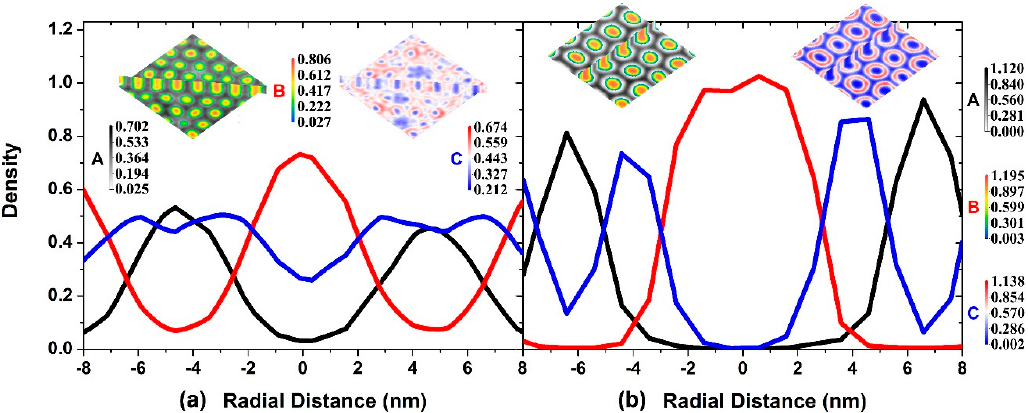
Figure 3. For 3C4 systems at the final equilibrium state, whose density profiles of A, B, and C beads of randomly selected individual cylinders under ( a ) the C[00] interaction and ( b ) C[55] interaction, starting from the center point of the cylinder (set as the original point) and moving along the radial direction, and denoted in black, red, and blue lines, respectively. Accordingly, two density images are inserted and whose color maps of A, B, and C beads are in white–black, reverse rainbow, and blue–white–red, respectively. Each density image consists of two density slices; one density slice is along the X–Y plane, and the other density slice goes through the cylindrical axis along one cylindrical array, with the latter one being vertical to the former one.